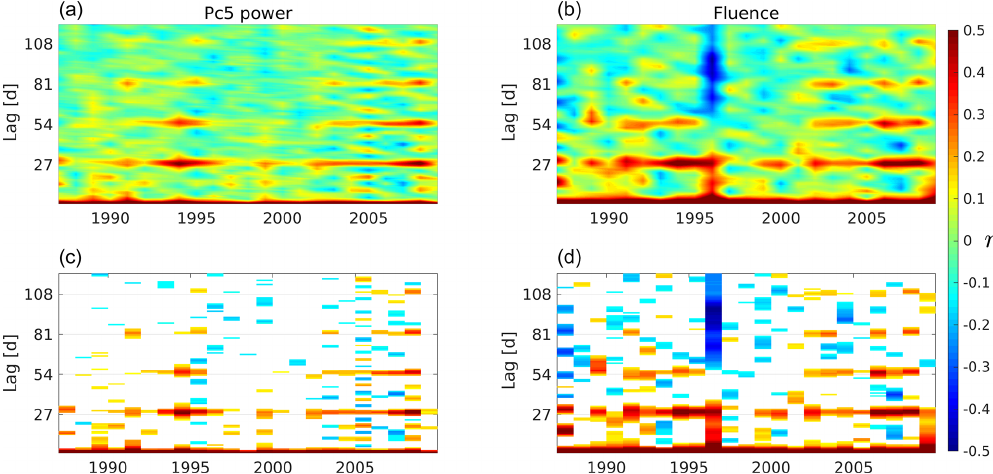
Figure 5. The 2D plots of ACFs of every year. In the horizontal axis is the year and in the vertical axis is the lag (between 0 and 120d). Panels (a) and (b) show the Pc5 power and fluence ACFs, respectively, with the neighboring values interpolated. White bins in panels (c) and (d) belong to | r | values that do not exceed | CVC |